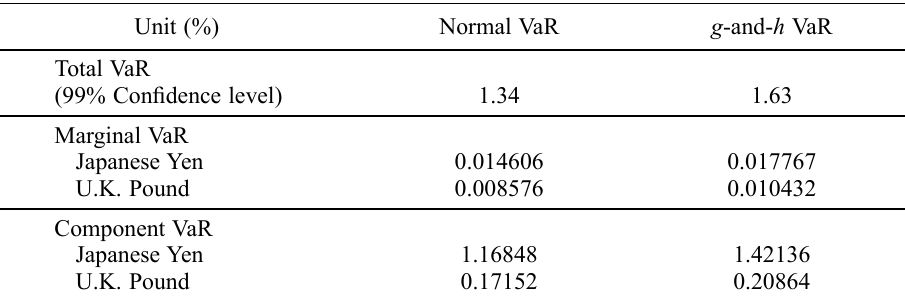
Table 3. Decomposition of portfolio VaR Unit (%) Normal VaR g -and- h VaR Total VaR (99% Confidence level)